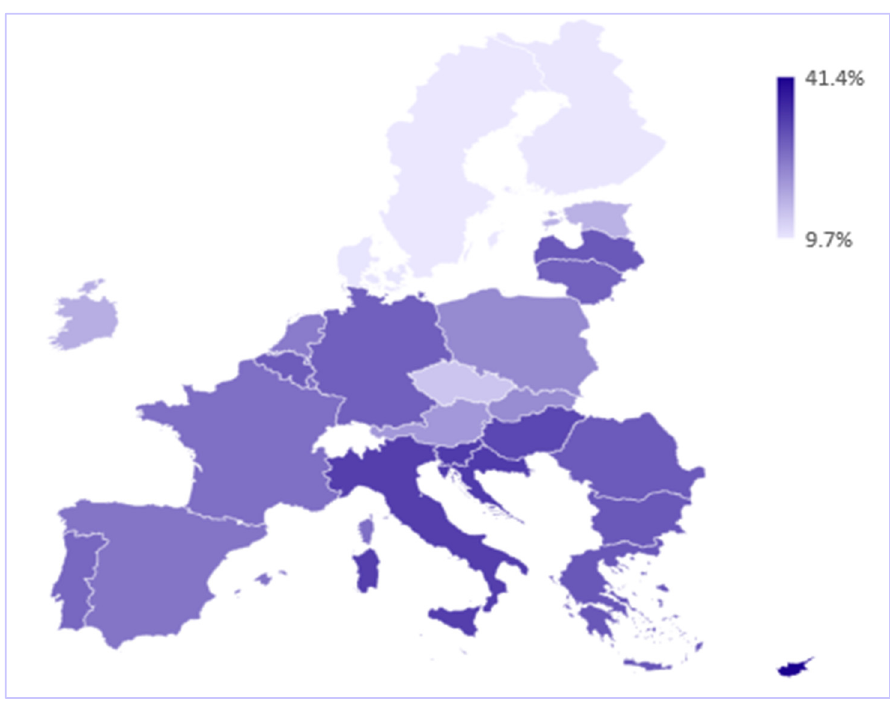
Figure 4. Share of individuals agreeing with the development of a European health policy, 2021. Source: Authors’ calculation using SPSS and Excel.